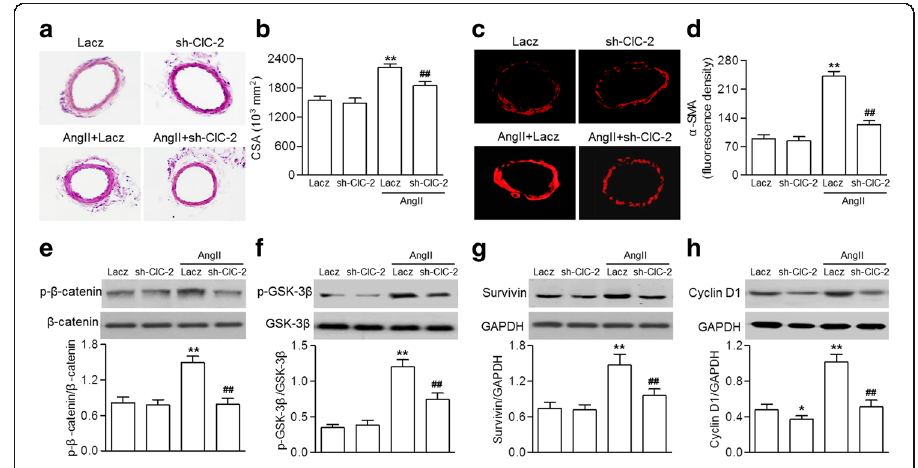
Fig. 5 ClC-2 deficiency blocked cerebrovascular remodeling. a C57BL/6 mice were injected with ClC-2-shRNA adenovirus (sh-ClC-2) or Lacz adenovirus before AngII infusion. Representative images of hematoxylin and eosin staining of basilar arteries. b Vascular remodeling was evaluated based on the cross-sectional area (CSA). c Representative images of immunofluorescence staining for α -SMA expression. d Bar graph showing the the relative fluorescence density values for α -SMA expression. e through h β -catenin ( e ) and GSK-3 β ( f ) phosphorylation, and survivin ( g ) and cyclin D1 ( h ) protein expression were determined via western blotting. * p <0.01, ** p <0.01 vs. Lacz, ## p <0.01 vs. AngII+Lacz, n =8 mice in each